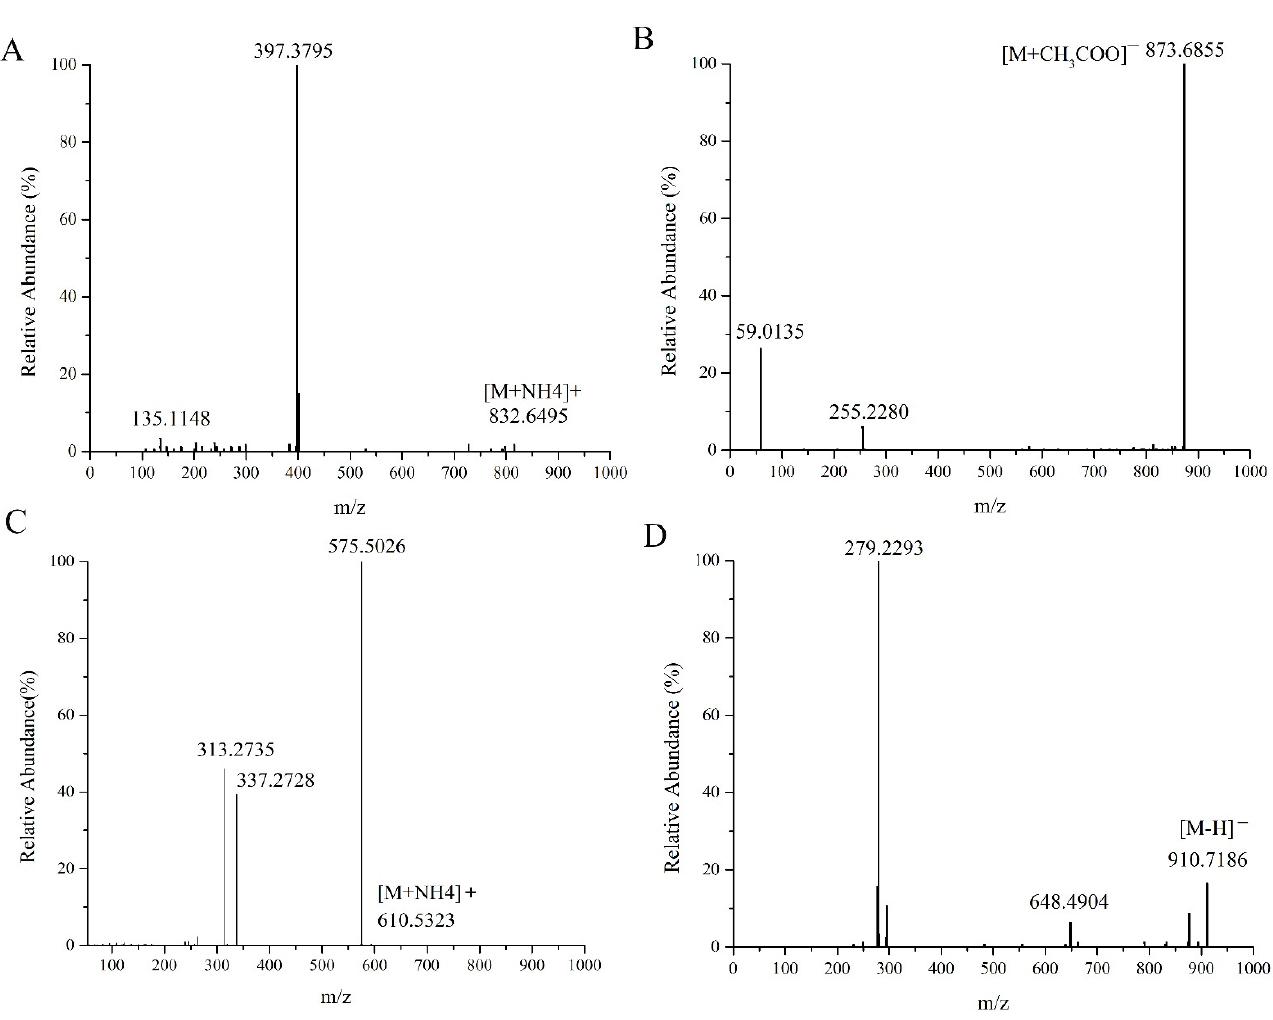
Figure 1. MS/MS spectra of ASG 29:1; O;Hex;FA 16:0 ( A ), DG 34:2 |DG 16:0_18:2 ( C ) in the positive ion mode and ASG 29:1;O;Hex;FA 16:0 ( B ), Cer 60:12 ( D ) in the negative ion mode.